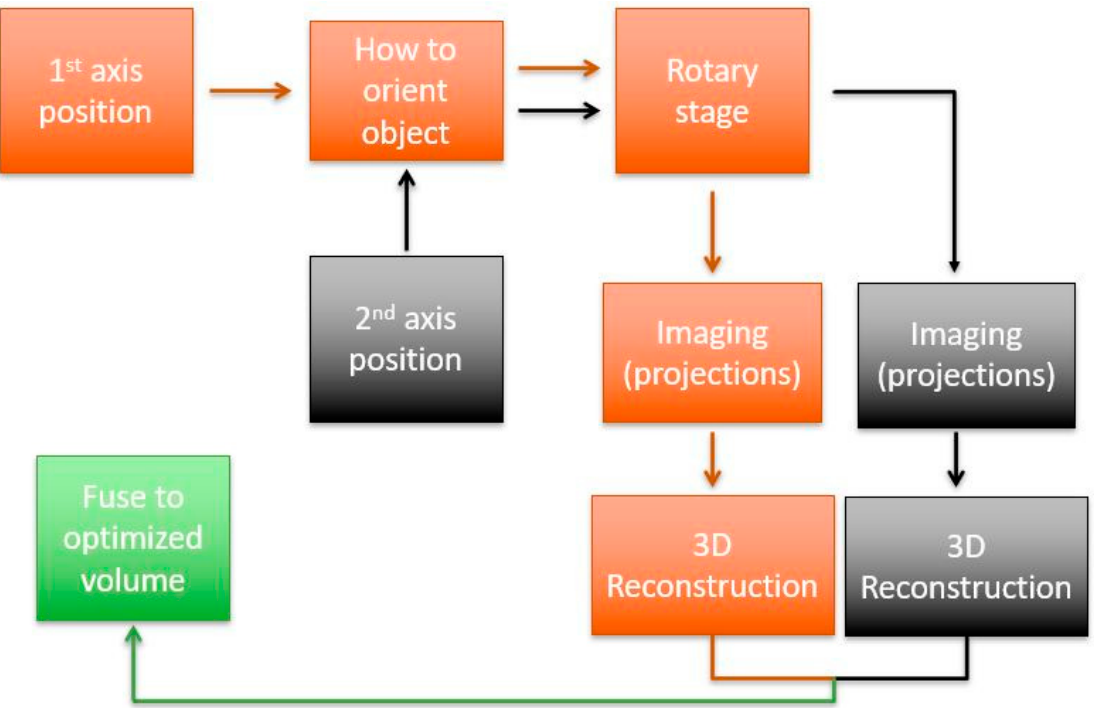
Figure 5. Partial architecture based on “Artifact reduction in X-ray computed tomography by multi-positional data fusion using local image quality measures” by Herl et al. [29] .